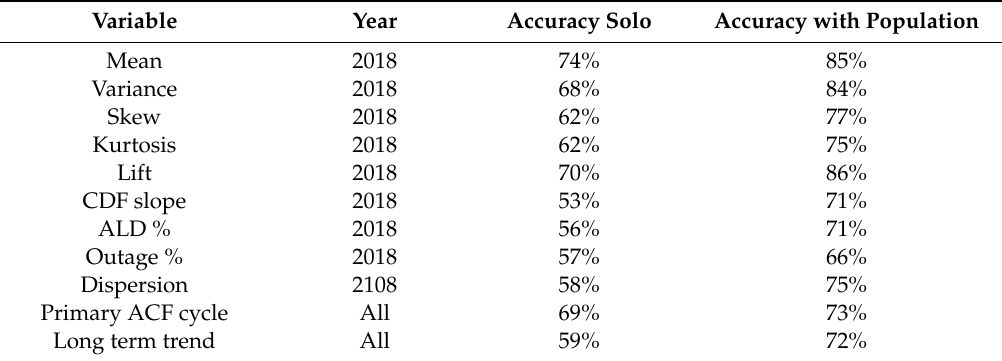
Table 2. Index classification accuracies for a developed (Houston, Seoul, Shanghai, Beijing) and developing set (Harare, Nairobi, Dhaka, Pyongyang).